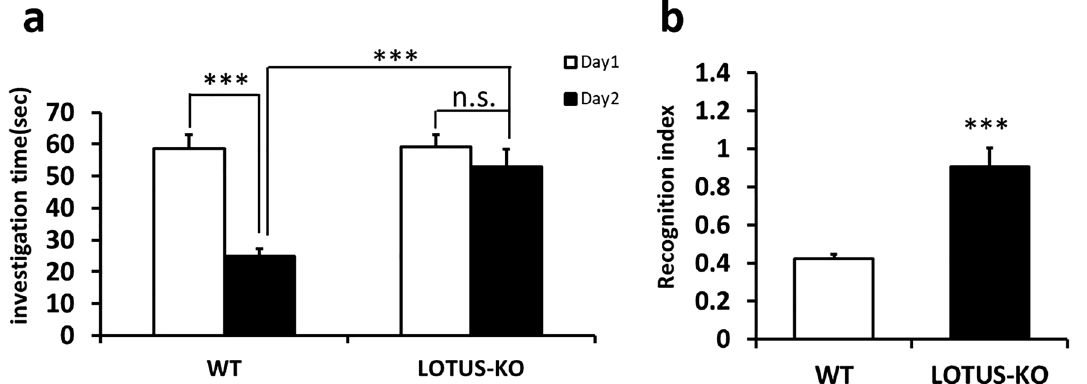
Figure 4. Loss of LOTUS causes impairment in social cognitive memory. ( a ) Comparison of the social investigation time during 3 min of exposure time. Data are means ± SEM from WT mice (n = 9) and LOTUS-KO mice (n = 10). *** P < 0.001, Day1 versus Day2, Student’s paired t -test, WT mice versus LOTUS-KO mice, Student’s unpaired t -test. ( b ) Recognition index. Data are means ± SEM from WT (n = 9) and LOTUS-KO (n = 10) mice. *** P < 0.001, Student’s unpaired t